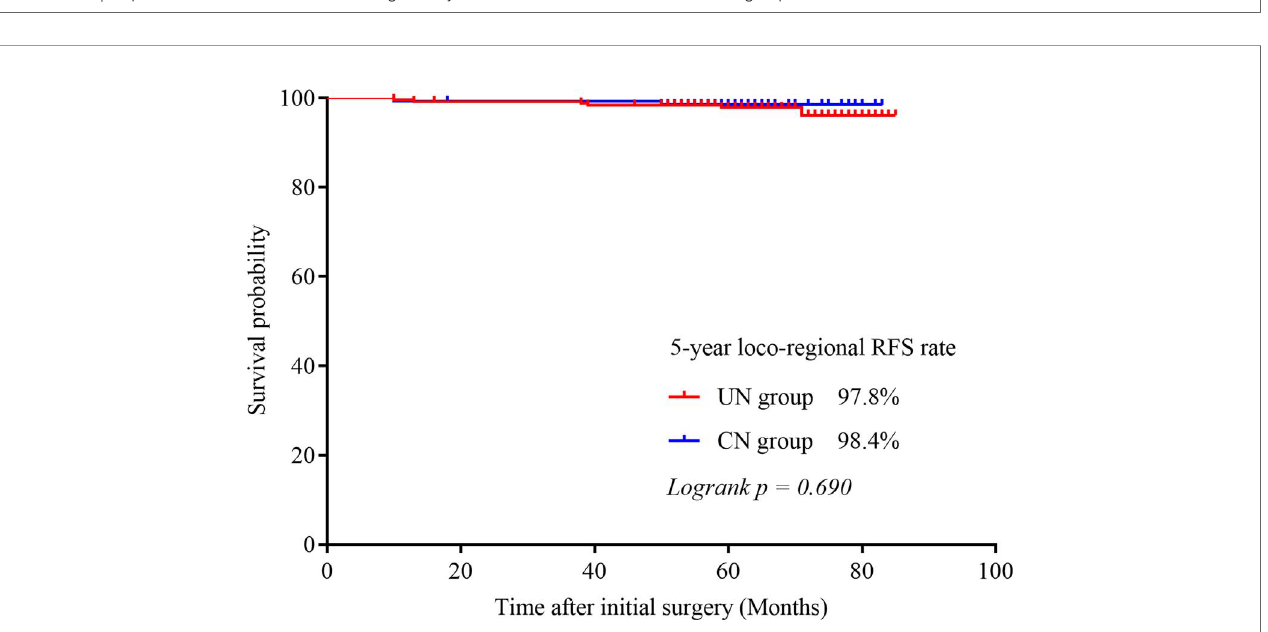
FIGURE 1 | Kaplan – Meier survival curve illustrating the 5-year contralateral lobe RFS rate in both groups.